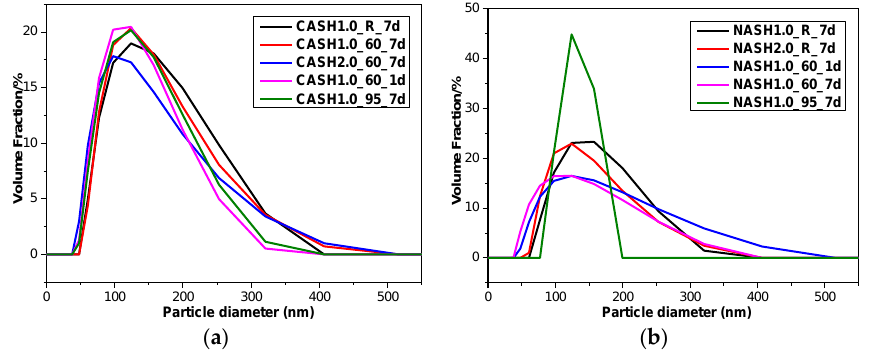
Figure 13. Particle size diameter distribution of the C-A-S-H and N-A-S-H products. ( a ) C-A-S-H system products; ( b ) N-A-S-H system products. Table 4. Average particle diameter of selected samples.